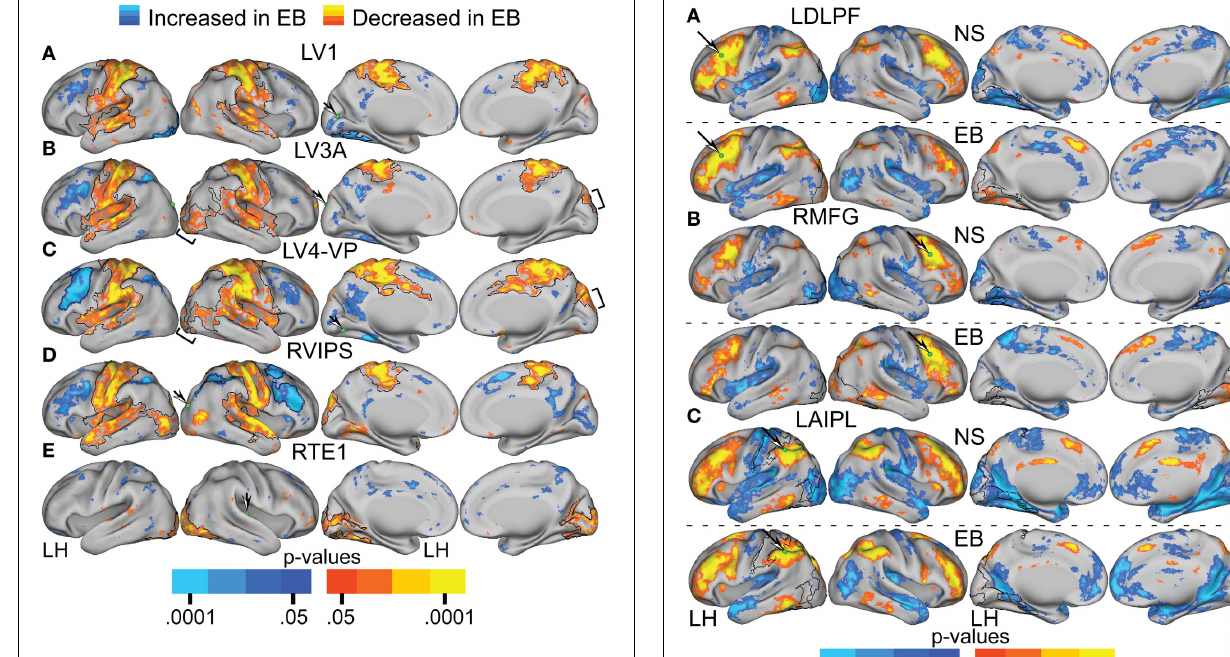
FIGURE 5 | Contrast of NS compared to EB functional connectivity based on two-tailed t- test for selected sensory seed regions (A–E) identified in Table 2. The t- statistic maps show positive t- test values (orange to yellow) where NS had greater positive correlations and/or EB had greater negative correlations. The t- statistic maps show negative t- test values (dark to light blue) where NS had larger negative correlations and/or EB had larger positive correlations. Black borders surround significant contiguous clusters identified using the threshold-free cluster enhancement assay (see Methods). An arrow points at a green sphere that marks the location of the seed region in each map.